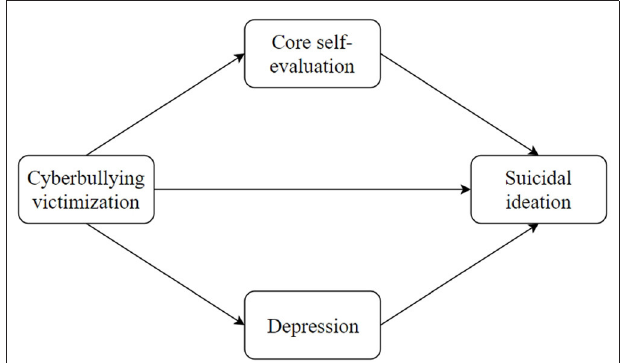
FIGURE 1 | Proposed conceptual